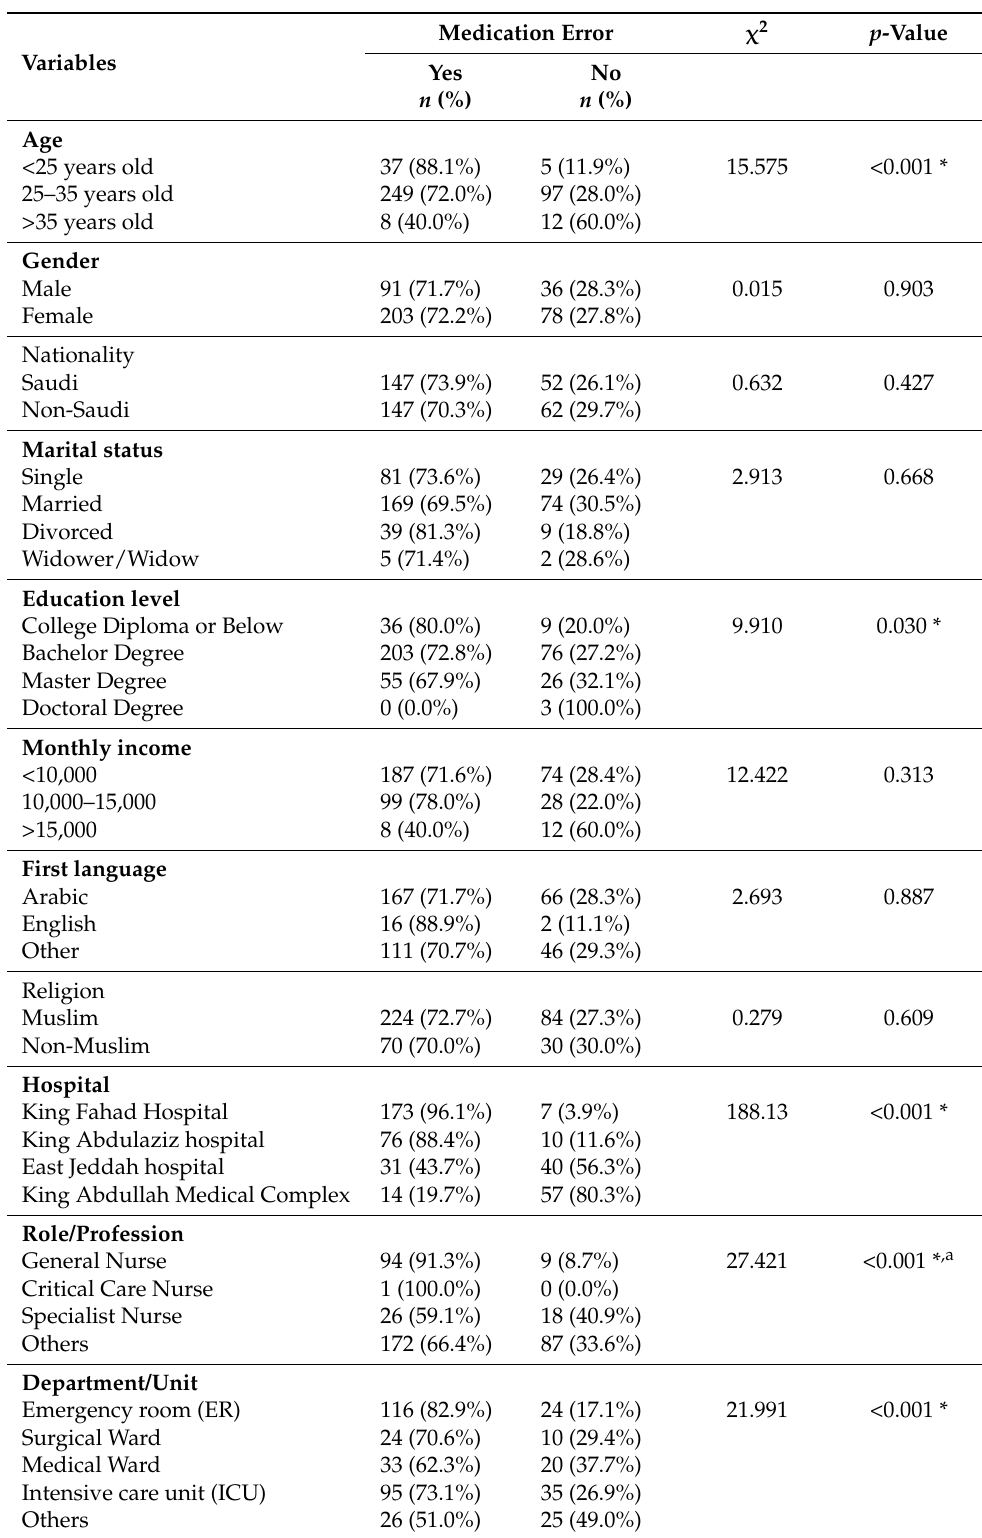
Table 5. Association between medication errors and nurses’ socio-demographic factors, cultural factors, knowledge, and